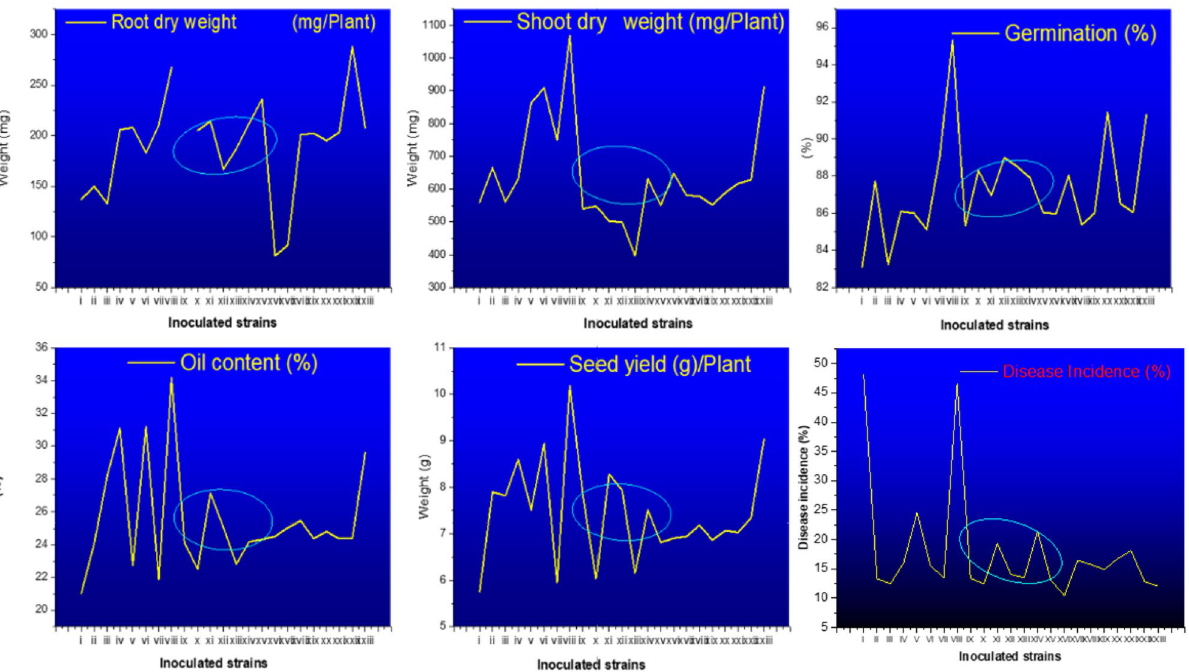
Figure 7. Effect of isolated microflora on growth and yield of B. rapa under pot house conditions. Symbols: I: Control; II: skuast2; III: SKUAST-K4; IV: SKUAST-K10; V: SKUAST-K11; VI: SKUAST-K12 ; VII: